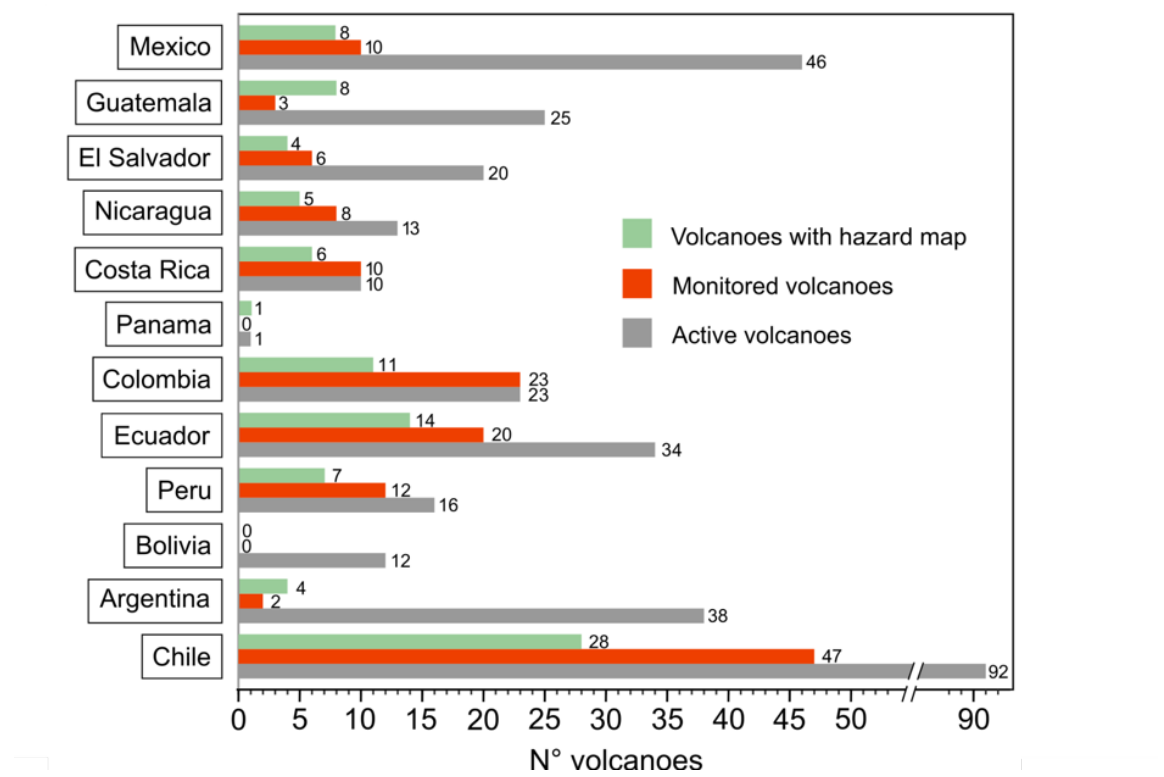
Figure 2: Plot showing the number of volcanoes monitored in Latin America, together with the hazard maps avail- able. For each country, the number of active, monitored and “with hazard map” volcanoes are shown, from bottom to top. Data of active and monitored volcanoes were collected from the different Reports of this Special Issue. For details about the hazard map data, see the Supplementary Material